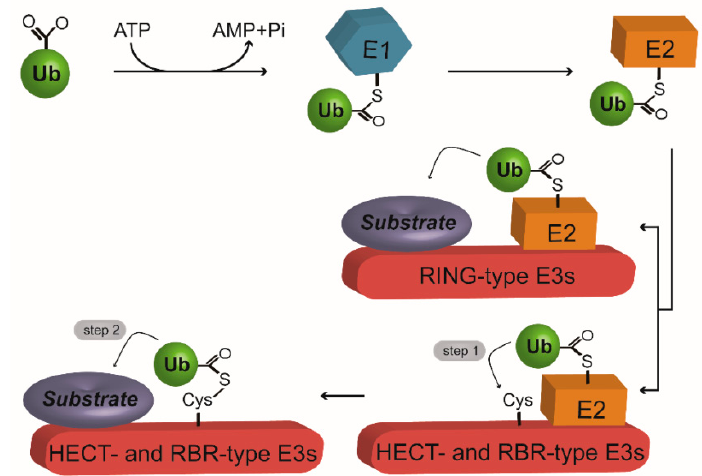
Figure 1. The ubiquitination machinery. Ubiquitination is initiated by E1-mediated ubiquitin (Ub) activation. Next, Ub is transferred to E2 to form an E2-Ub conjugate. At the final step, E3 mediates isopeptide bond formation between the Ub and the substrate. Really interesting new gene (RING)-type E3s serve as a scaffold to directly transfer the Ub from E2 to the substrate. On the other hand, homologous to E6-AP COOH terminus (HECT)- and RING between RING (RBR)-type E3s require a two-step reaction to achieve Ub ligation with the substrate. In the first step, Ub is transferred from E2 to E3, producing an E3-Ub thioester intermediate. At the second step, Ub is finally handed over to the substrate. Arrows represent the next steps during the process of ubiquitination.